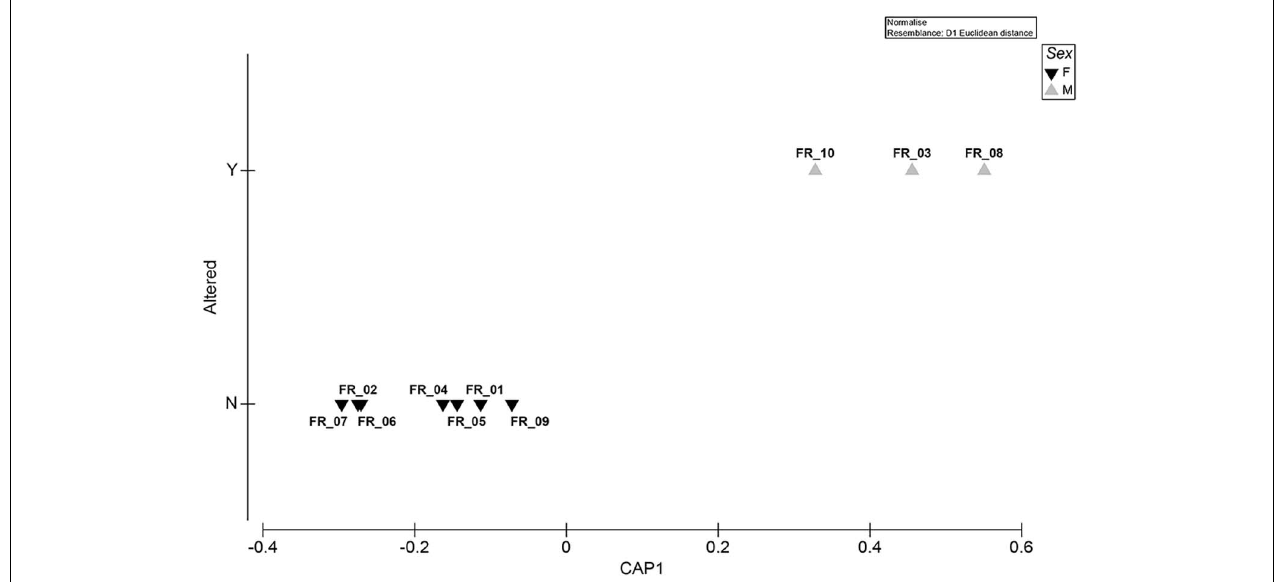
FIGURE 7 | Exploratory MVA analysis. Canonical analysis of principal coordinates run on a Euclidean distance biomarker matrix. The “Sex” factor is superimposed as plot symbols. Correlation equaled